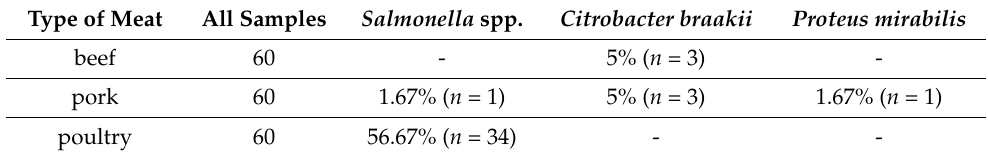
Figure 1. Citrobacter braakii from a meat sample of ( A ) beef and ( B ) pork, and Salmonella Enteritidis from a meat sample of ( C ) poultry, on XLD media. Table 1. Incidence of Salmonella spp., Citrobacter braakii , and Proteus mirabilis in meat